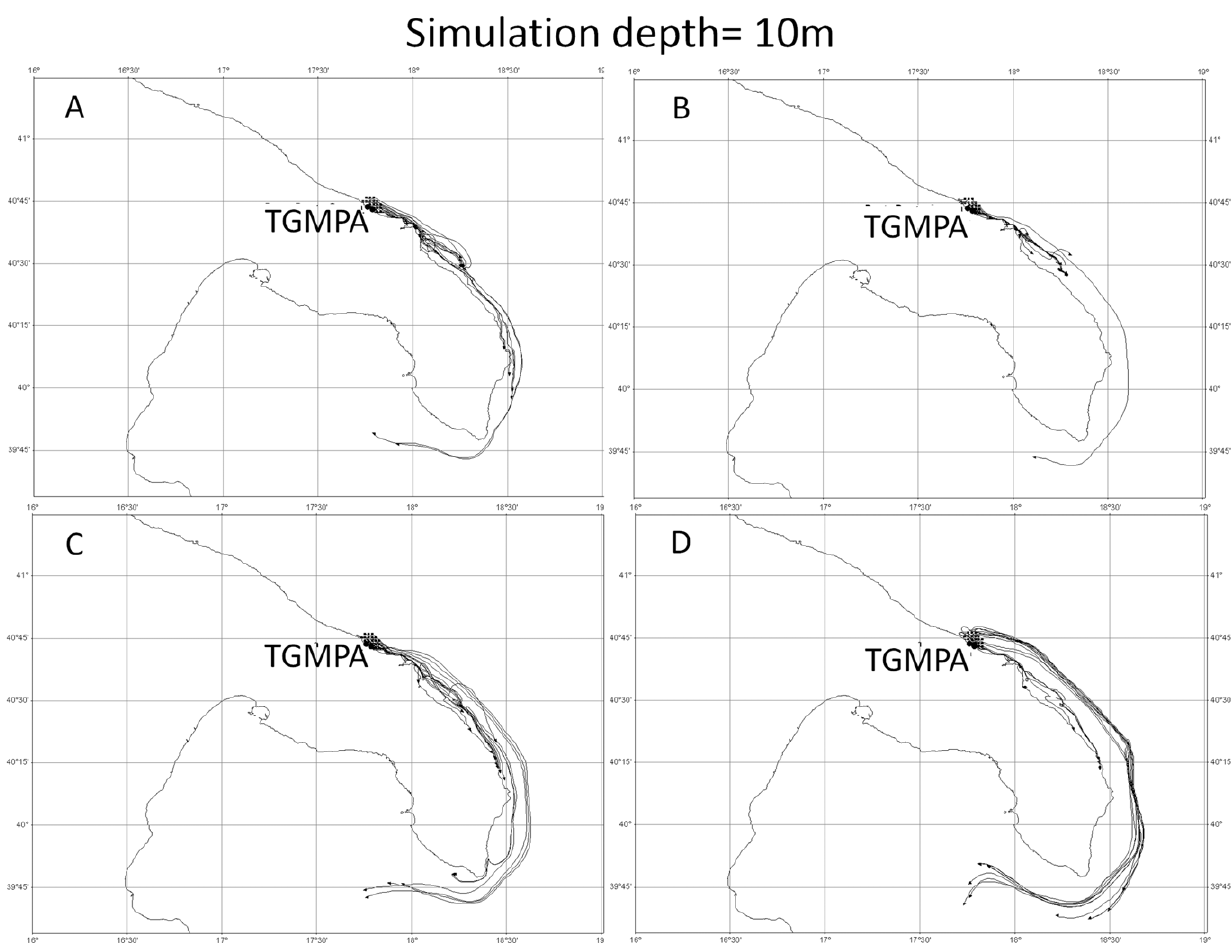
Figure 7. Four Lagrangian simulations at 10 meter depth. Simulations started respectively a) on 9 th , b) 11 th , c) 13 th , d) 15 th of May. All simulations lasted 17 days.